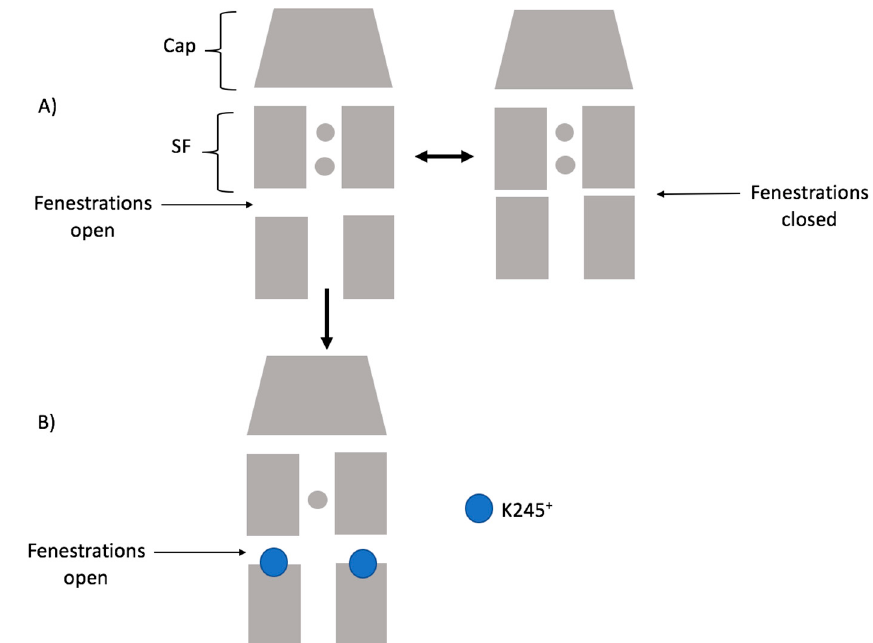
Figure 9. K245 + would preclude the fenestration closing in TASK-2 from the down-state. ( A ) The channel could switch from a down-state to an up-state; ( B ) In the down-state, K245 protonates and prevents K + flux.